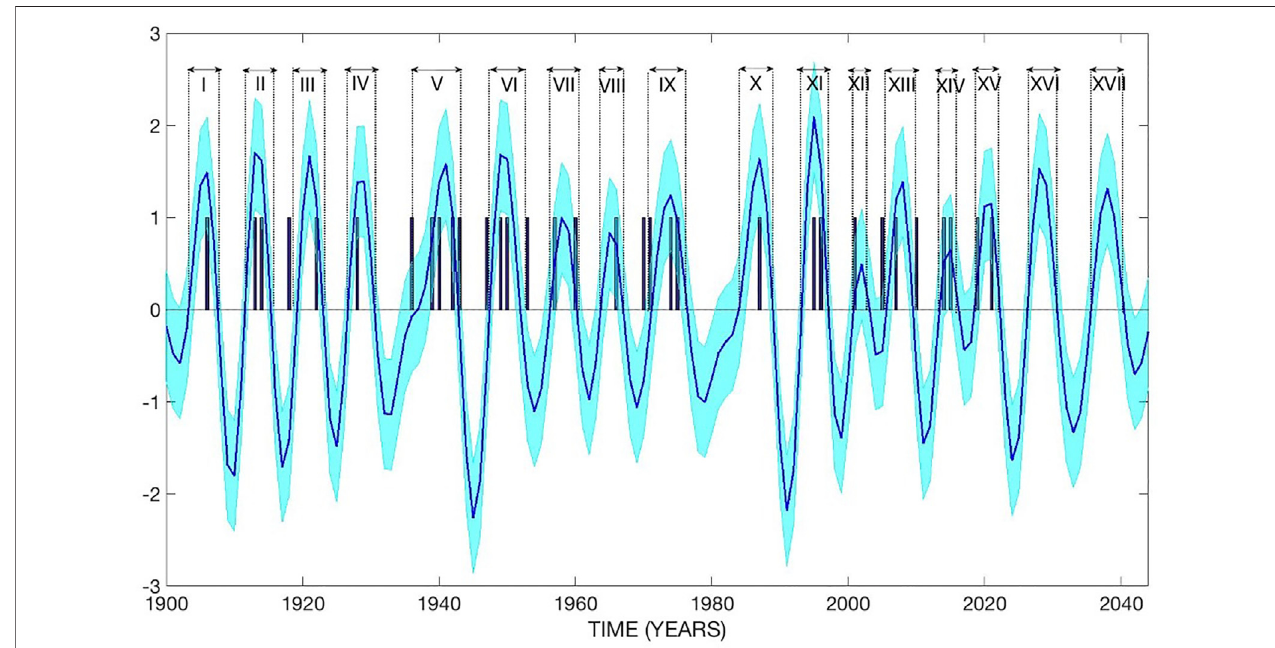
FIGURE 8 | Probabilistic earthquake prediction for the South America ( M ≥ 7). Bayesian inference of LS-SVM model (blue line amd shade) compared with the historicalearthquakesclusteredin fi fteengroups(I-XV)andshownwithverticalbluebarsfrom1900to2021.Inaddition,theprobabilisticearthquakepredictionisshown for the following two periods (cluster XVI and XVII). The blue shaded area represents the 95% con fi dence intervals of the Bayesian model.